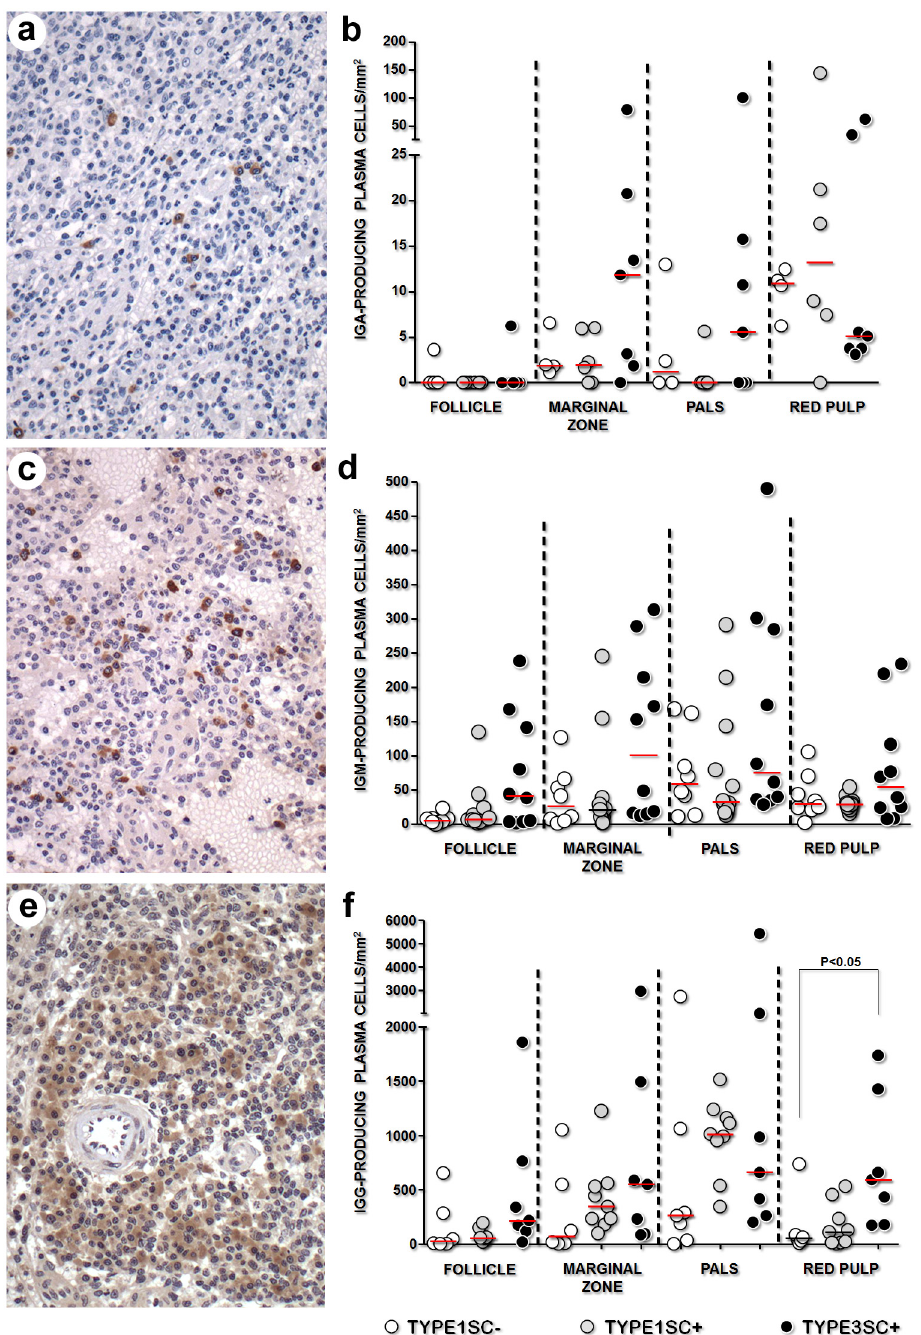
Fig 2. Isotype of the immunoglobulins produced by plasma cells in dogs with normal spleens and inactive (TYPE1SC-) or active (TYPE1SC+) Leishmania infection, or those with disorganized white pulp and active Leishmania infection (TYPE3SC+). (Kruskall-Wallis test). a and b correspond to IgA; c and d correspond to IgM and e and f correspond to